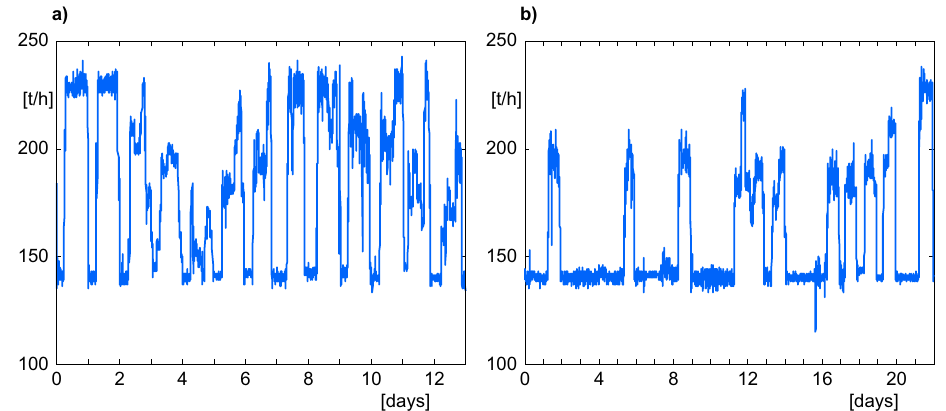
Figure 3. Daily variability of the steam boiler load for time periods described in Section 5.3: ( a ) 04.12.2011. ( b )